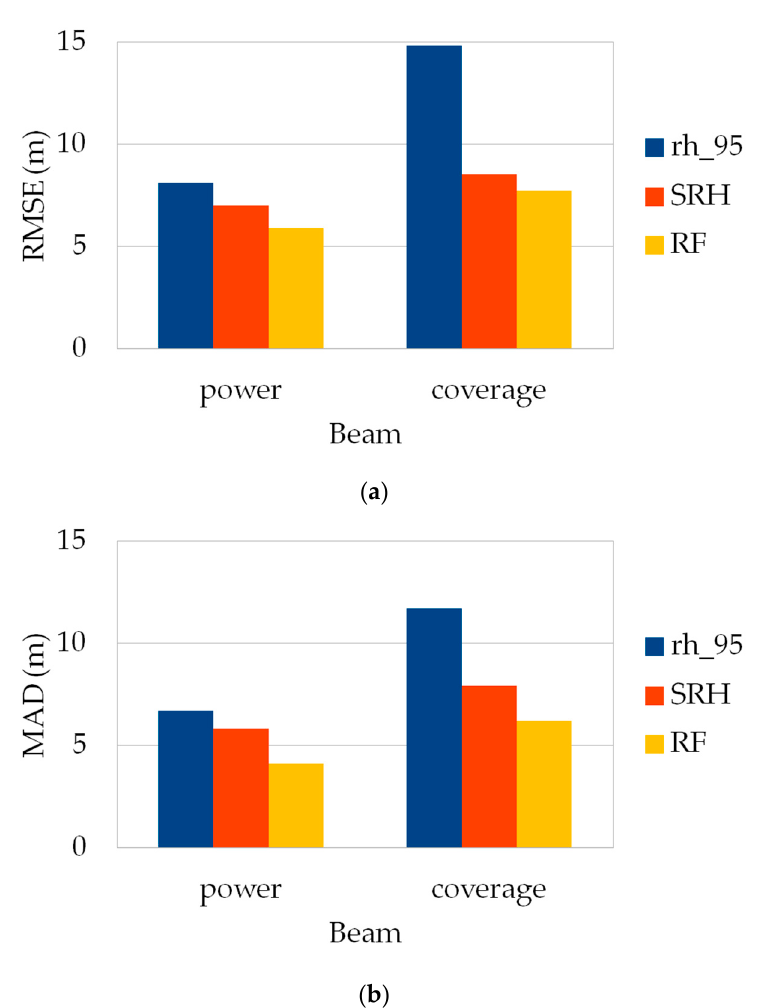
Figure 8. RMSE ( a ) and MAD ( b ) for GEDI-CHM estimators (10-fold cross validation, whole dataset) depending on beam type (algorithm setting group number 5): direct estimation, SRH and RF.